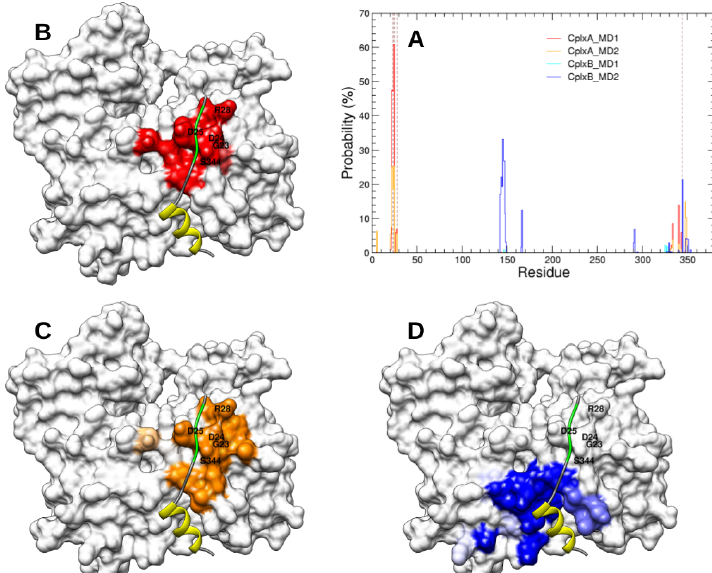
Figure 6. ( A ) Probability of actin residues to be distant by less than 4 Å from N-WASP segments 22 LKKV 25 or 50 LKSV 53 in CplxA_MD1 (red), CplxA_MD2 (orange), CplxB_MD1 (cyan), and CplxB_MD2 (blue). Brown dashed lines indicate the actin residues (G23, D24, D25, R28, and S344) in contact with N-WASP segment 50 LKSV 53 in structure 2VCP [27]). ( B – D ) Front views of the actin’s surface colored proportionally to the previous probabilities. Red, orange, and blue colors indicate actin residues with high probabilities to be contacted by N-WASP segments 22 LKKV 25 or 50 LKSV 53 in simulations CplxA_MD1 ( B ), CplxA_MD2 ( C ), and CplxB_MD2 ( D ), respectively. As a reference, yellow and green ribbons represent the helical region and the conserved sequence LKSV of the second WH2 motif observed in structure 2VCP [27].